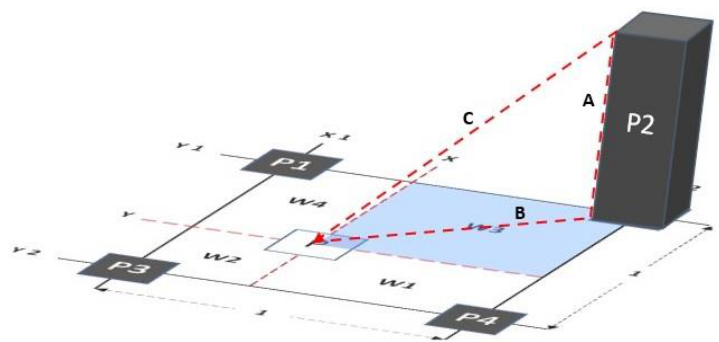
Figure 6. Example showing the virtual pixel length-based height for the area of the triangle weighting scheme—this is the AT weighting scheme.